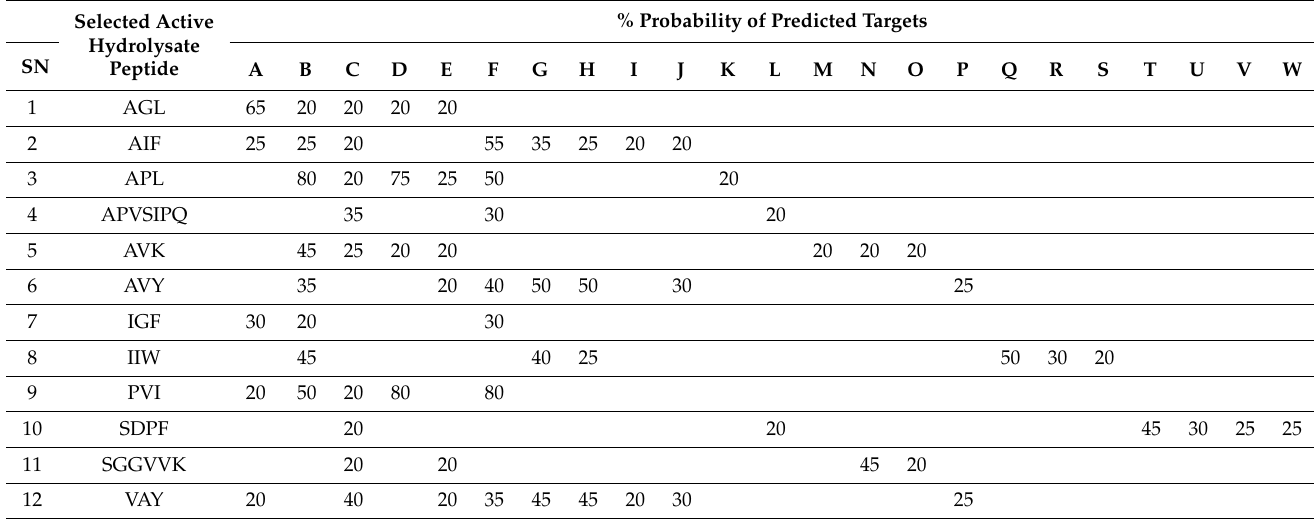
Table 1. Molecular targets of hydrolysate peptides predicted from SwissTargetPrediction.